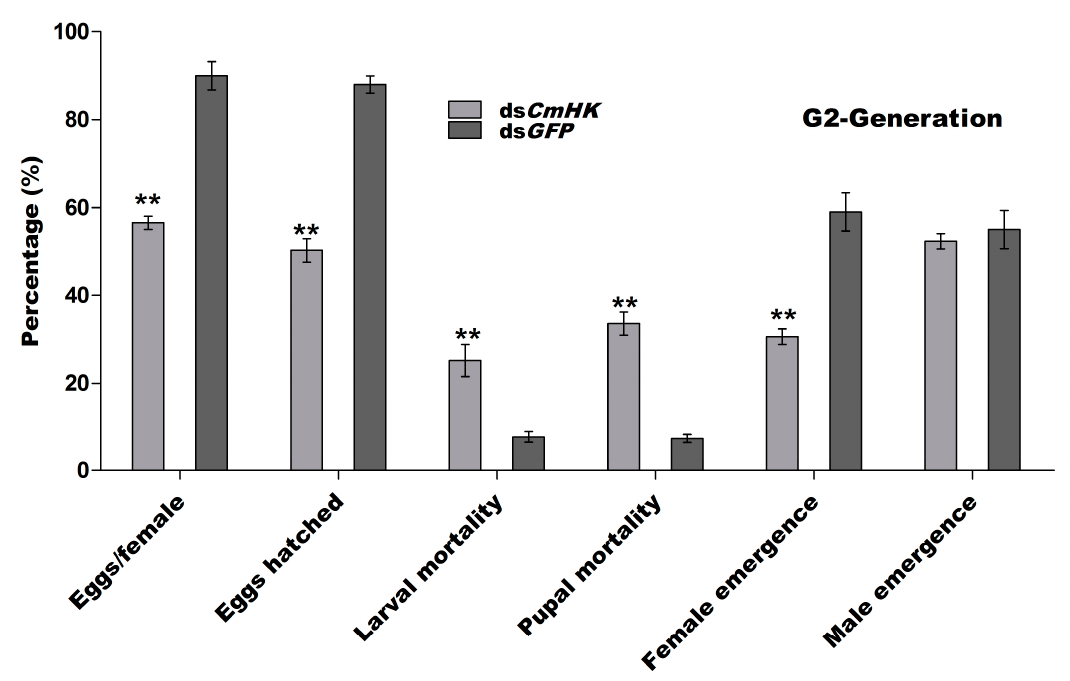
Figure 8. Five pairs of male and female adults emerged from G1 were selected for G2-generation. The percentage of eggs per female, eggs hatched, larval mortality, pupal mortality, male emergence, and female emergence were observed. Each bar indicates the mean ± SD from the CmHK and GFP groups. Significant differences are indicated by ** (P < 0.05).